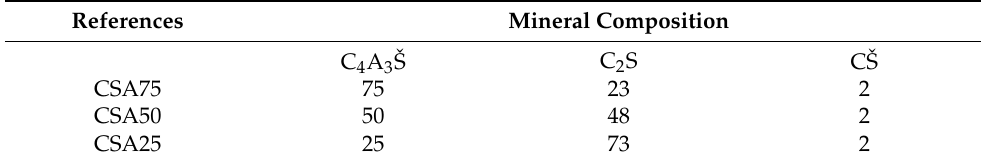
Table 1. Mineralogical composition of the three synthetized CSA clinkers (wt. %).